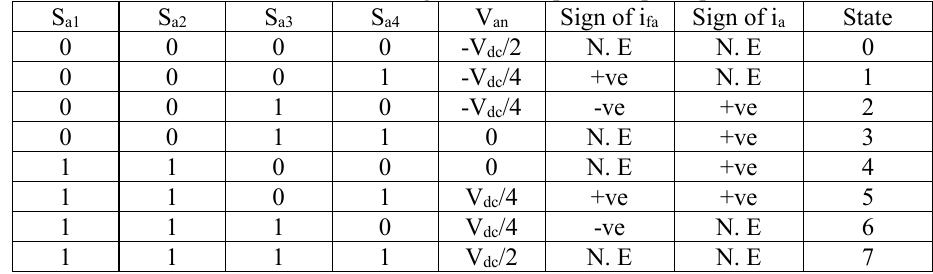
Fig. 1 . Structure of the one-leg 5LANPC TABLE 1. One leg 5LANPC operation